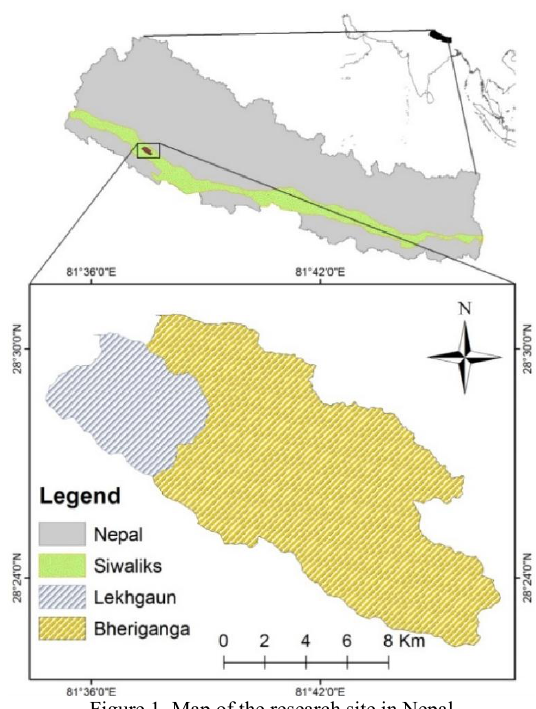
Figure 1. Map of the research site in Nepal